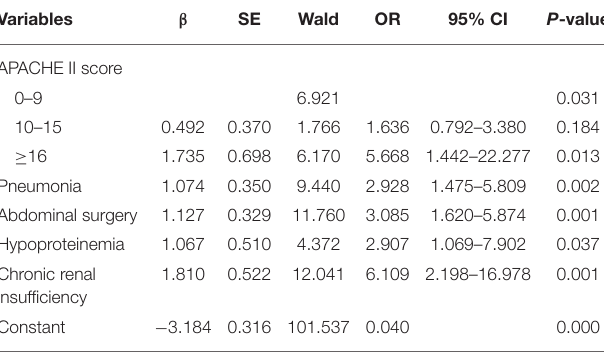
TABLE 3 | Second step of logistic regression analysis of risk factors of in-hospital death in patients with intra-abdominal infection.